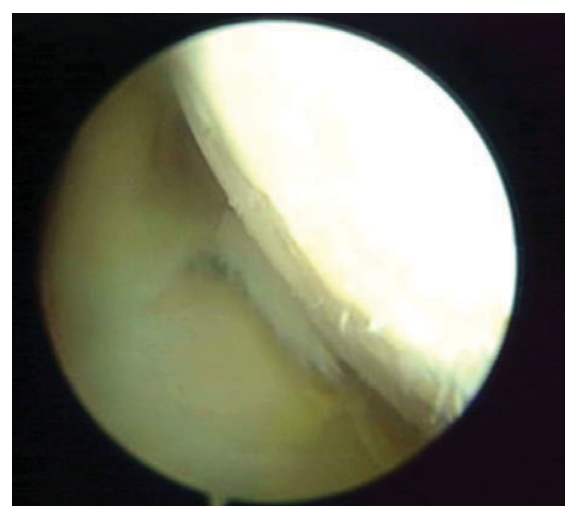
Figure 3. Typical SLAP type 2 lesion in the right